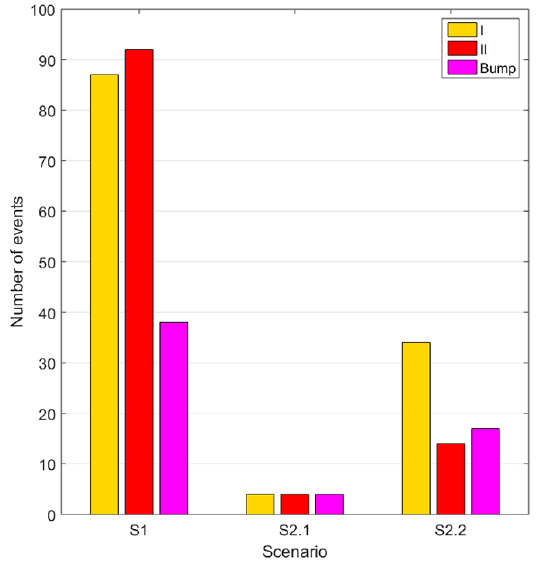
Figure 6. Statistics on the event type (I, II or bump) as a function of the scenario describing the location of the station in the tropospheric layers (see Table 3).